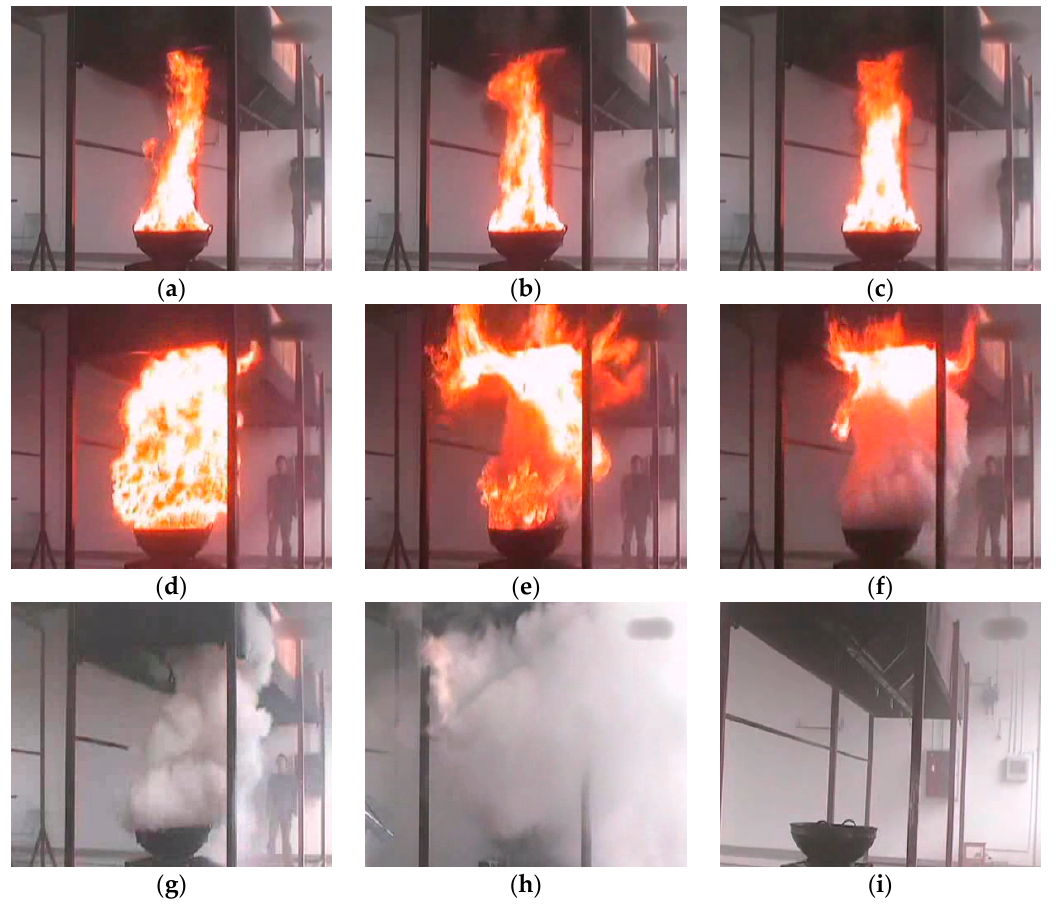
Figure 4. Candidate images: ( a – c ) stable burning of fire; ( d – f ) initial extinguishing of fire; ( g – i ) final extinguishing of fire.